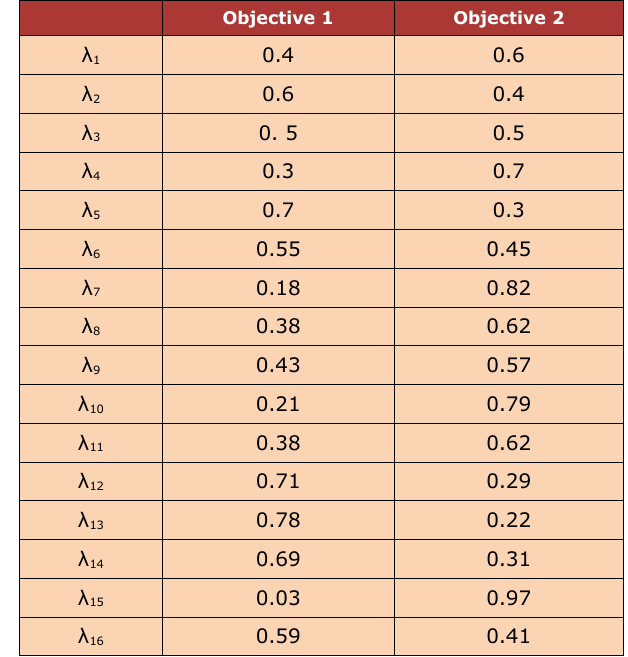
Table 16. Weight vectors for each objective